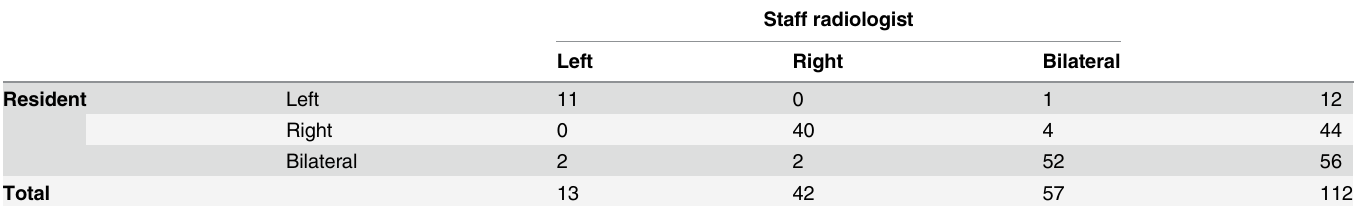
Table 2. PE location according to Staff Radiologists and Residents interpretations.